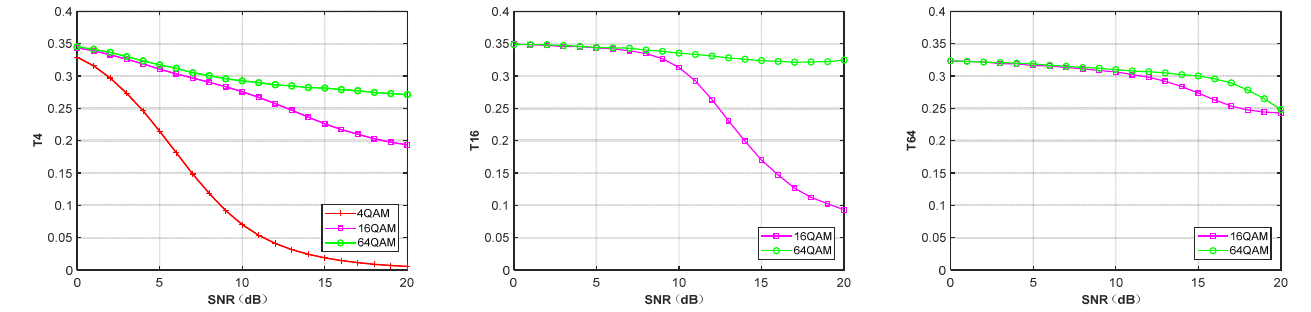
Figure 2. The mean hard tendency of T D of MQAM at N = 512.